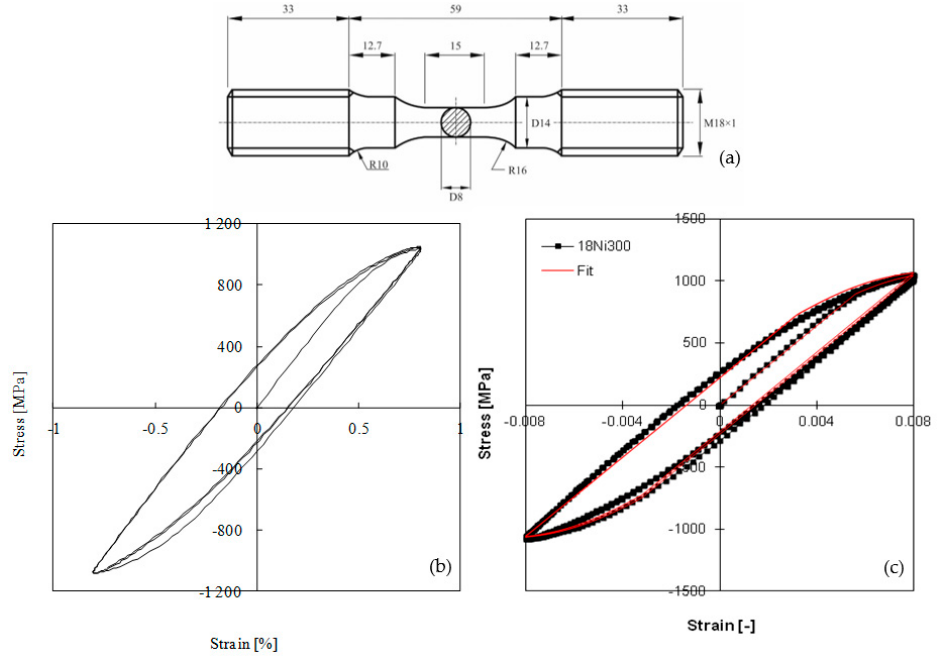
Figure 4. ( a ) Low cycle fatigue specimens. ( b ) Stress-strain plot ( ∆ ε = ± 0.8%). ( c ) Experimental versus fitted curve (18Ni300 steel).